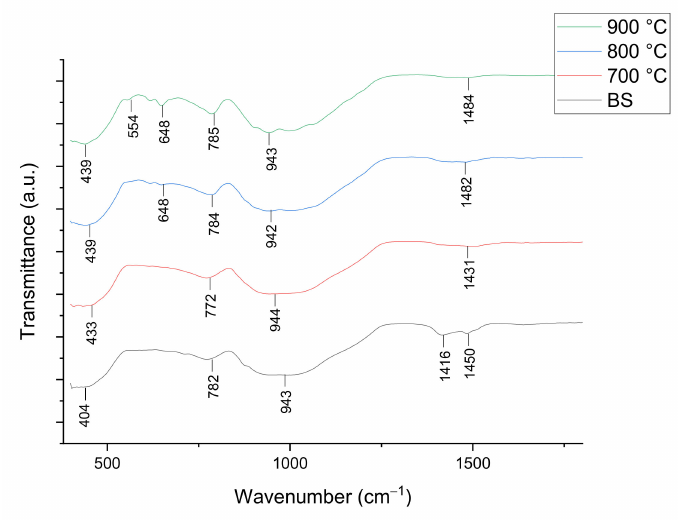
Figure 6. FTIR spectra of foam glass-ceramics 1 wt% sintered at various temperatures for 60 min.